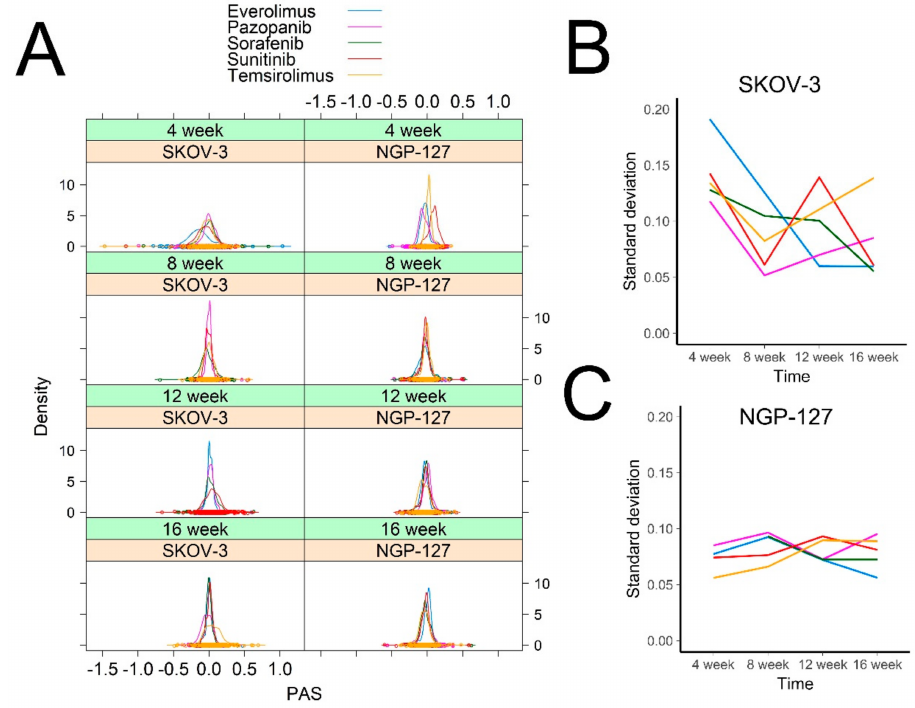
Figure 2. Distribution of PAS values over time. ( A ) A density plot was built for each cell line for each drug and for each timepoint. Each curve shows density of Pathway Activation Strength for 378 signaling pathways. Density plots were built using Lattice R package ( B , C ). Standard deviation of PAS values for SKOV-3 ( B ) and NGP-127 ( C ) cells treated with target drugs for 1 to 4